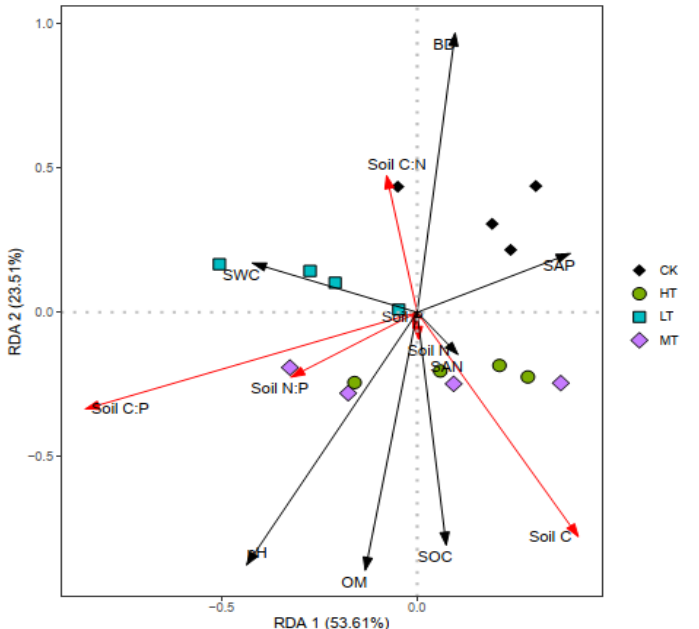
Figure 6. Ordination plots of the results of the redundancy analysis (RDA) identifying the relationships between soil properties (black arrows) and soil C:N:P stoichiometry (red arrows) among different thinning treatments.